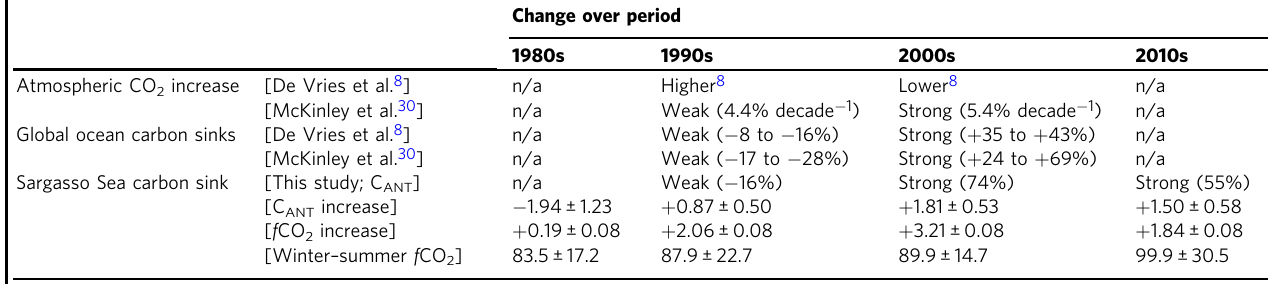
Table 3 Comparison of atmospheric CO 2 increase, global ocean carbon sinks and Sargasso Sea carbon sink for recent decades. Change over